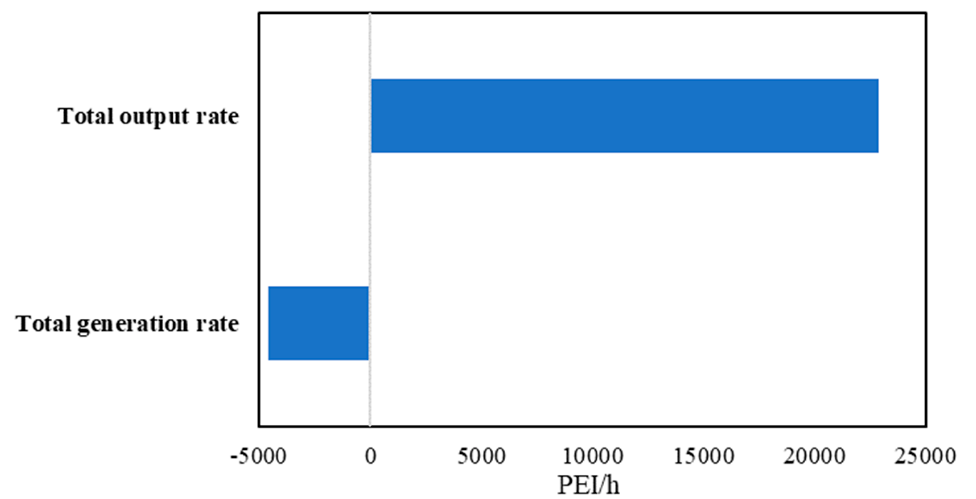
Figure 7. Total generated and output rates of potential environmental impact (PEI) for chitosan production from shrimp exoskeleton. Adapted from: [13].